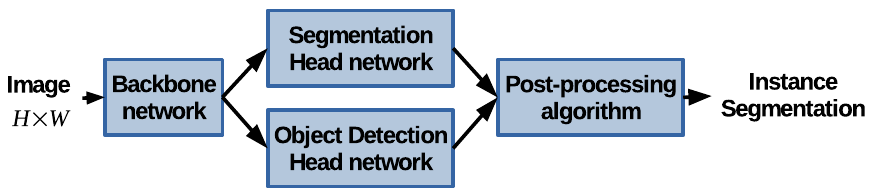
Figure 1. The instance segmentation scheme. The proposed method is obtained by modifying each block.